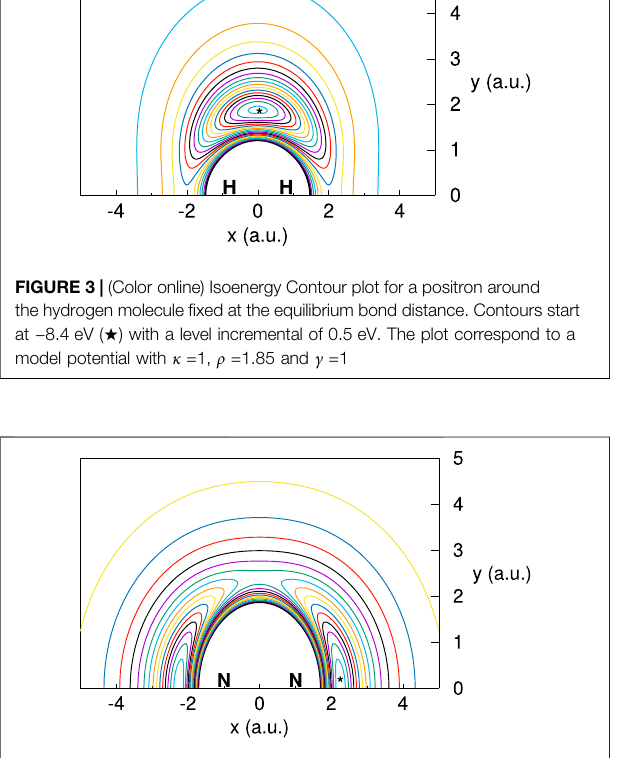
TABLE 1 | Parameters of the static potential, Eq. 3 (in a.u.). Parameter H 2